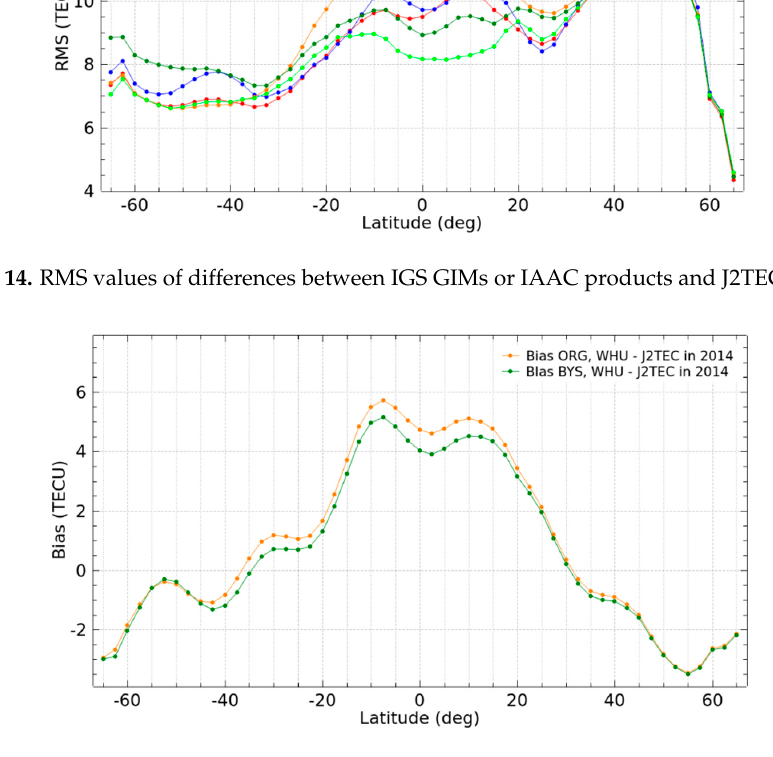
Figure 15. Bias values for comparison between WHU products and J2TEC in 2014. Remote Sens. 2018 , 10 , 63